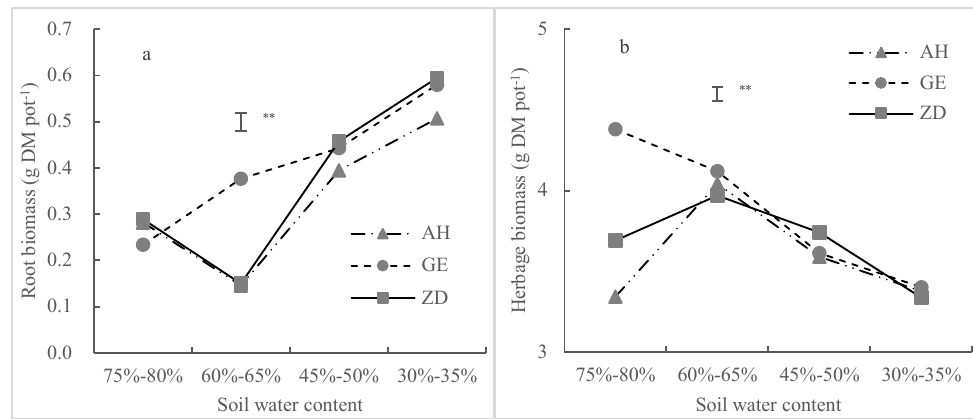
Figure 7. Interactions between soil water content (75–80%, 60–65%, 45–50%, and 30–35% of water-holding capacity) and cultivars (AH: Aohan; GE: Golden Empress; ZD: Zhaodong) on ( a ) root biomass and ( b ) herbage biomass of alfalfa. ** p < 0.01.